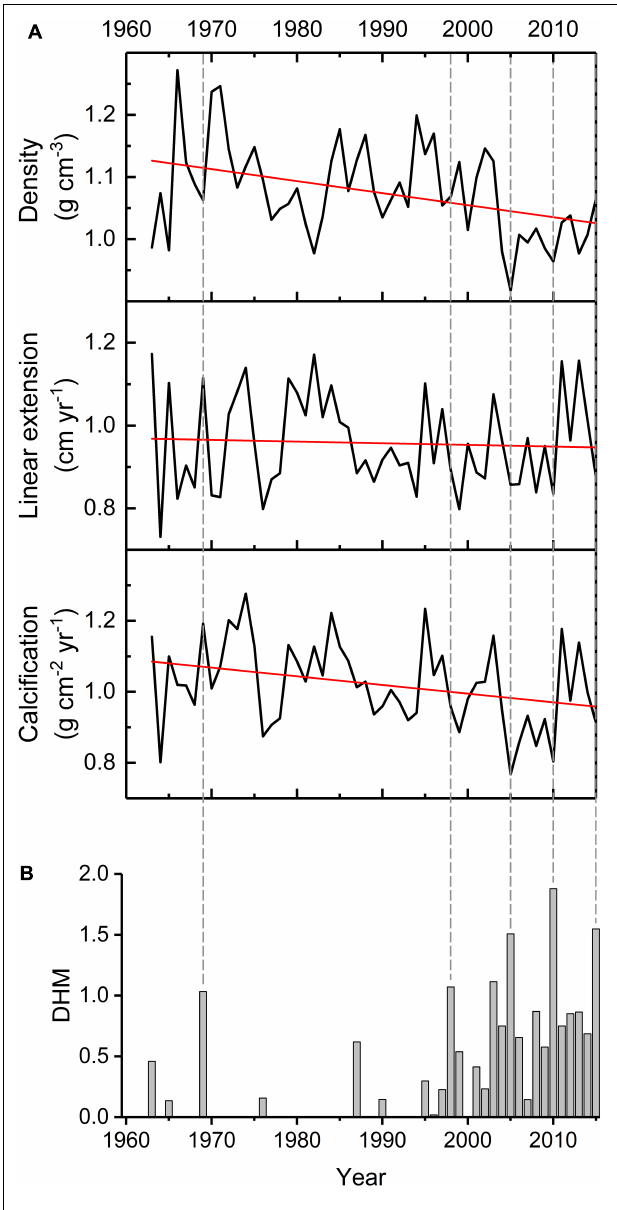
FIGURE 2 | Coral growth master chronologies during 1963–2015 for Serrana Atoll (black solid lines) (A) . Trends (red solid lines) are significant for density ( r 2 = 0.16, p = 0.004, n = 53) and calcification ( r 2 = 0.10, p = 0.021, n = 53), but not for extension ( r 2 < 0.00, p = 0.698, n = 53). The thermal stress index given by degree heating months (DHM) are represented by gray bars (B) . Dashed lines indicate the years (1969, 1998, 2005, 2010, and 2015) with the highest DHM values.